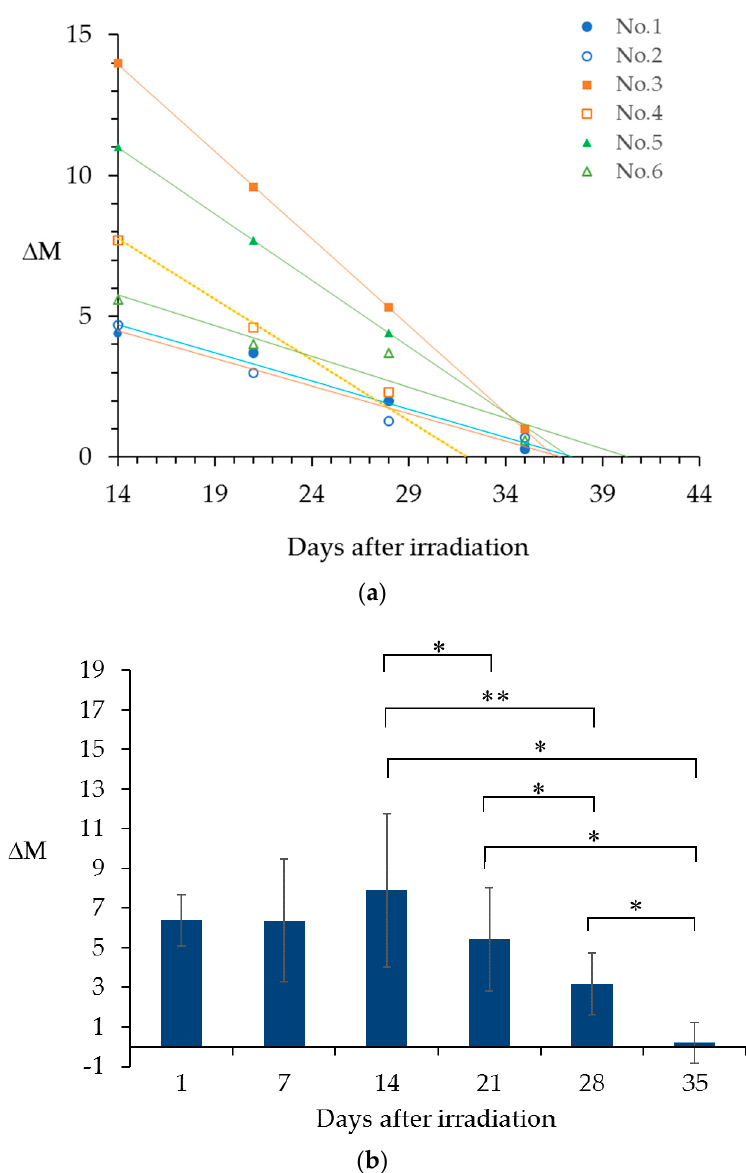
Figure 1. Time course of decrease in skin darkening produced by UVA irradiation of the inner male forearm. ( a ) The results are expressed as the Δ M of each subject. The change in skin darkening was evaluated in terms of Δ M, which was calculated by subtracting the Melanin Index (M) immediately before irradiation from M at each measurement time; ( b ) The results are expressed as the mean ± standard deviation of Δ M of six subjects. * p < 0.05 vs. 14 days after irradiation, and ** p < 0.01 vs. 14 days after irradiation.